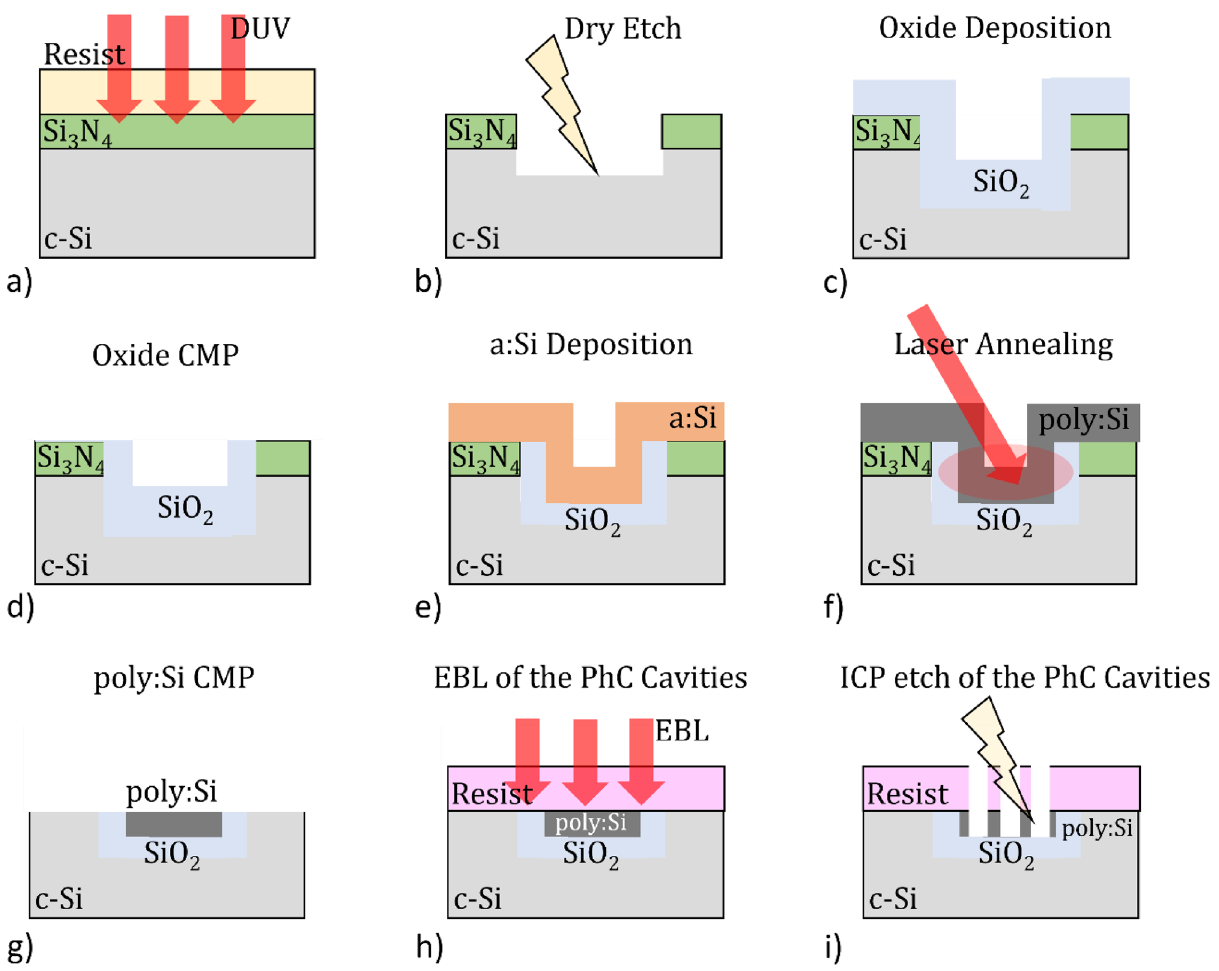
Figure 4. Fabrication workflow of the poly:Si on SiO 2 islands nested into bulk Si wafers: ( a ) a hard mask of Si 3 N 4 is deposited and a Deep-UV lithographic step is used to expose rectangles to be used as islands, ( b ) plasma etch of the hard mask and bulk Si, ( c ) PECVD of SiO 2 , ( d ) planarization of the SiO 2 , ( e ) low temperature PECVD of the a:Si, ( f ) laser annealing into poly:Si, ( g ) CMP of the poly:Si, ( h ) Electron-Beam Lithography of the PhC cavities and ( i ) their dry etch.